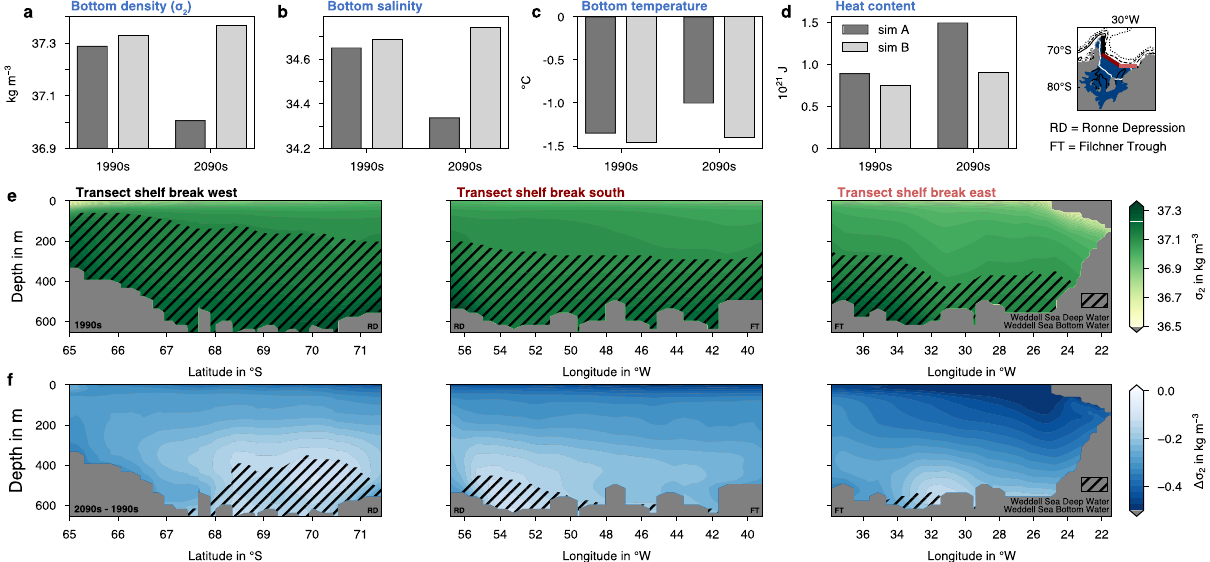
Fig. 6 Changes in water mass properties on the Weddell Sea continental shelf. a Bottom potential density anomaly ( σ 2 in kg m − 3 , i.e., potential density referenced to 2000dbar minus 1000 kg m − 3 ) on the shelf (blue area in the map) in the 1990s and 2090s in the experiment simA (dark grey; historical + SSP5-8.5 scenario) and in the control simulation simB (light grey). b – d Same as a , but for b bottom salinity, c bottom potential temperature in ∘ C, and d total heat content in 10 21 J. e Distribution of σ 2 at a transect along the continental shelf break (see map) in the 1990s of simA . f Same as e , but for the change in σ 2 between f the 2090s and the 1990s. Hatching in e , f denotes the presence of Weddell Sea Deep Water and Weddell Sea Bottom Water in the e 1990s and f 2090s, de fi ned in the model as waters with a potential temperature < − 0.2 ∘ C and a practical salinity >34.55. The approximate positions of the Ronne Depression (RD) and the Filchner Trough (FT) are